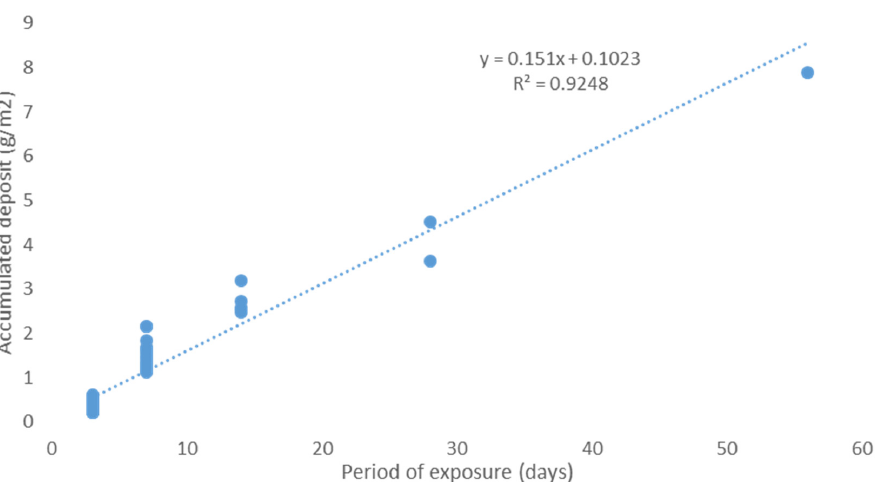
Figure 6. Correlation between the accumulated deposit (g/m 2 ) and period of exposure (days) for both the rainy and dry season.